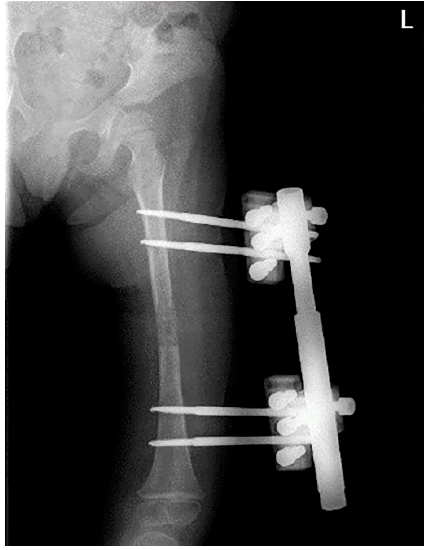
Figure 3. Postoperative x-ray of left femur after osteotomy and monofixator applied.